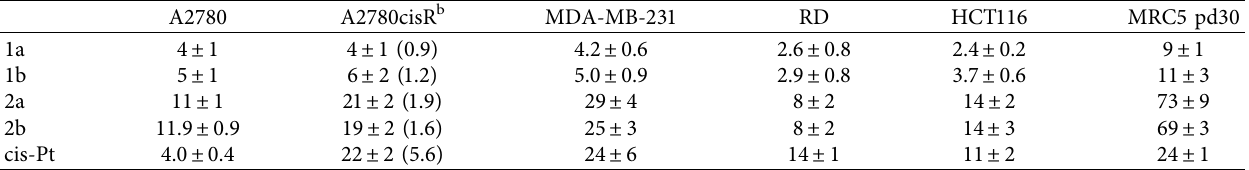
Table 1: IC a ( μ M) obtained for 1a , 1b , 2a , 2b , and cisplatin by MTT assay after 72h of incubation. 50 values